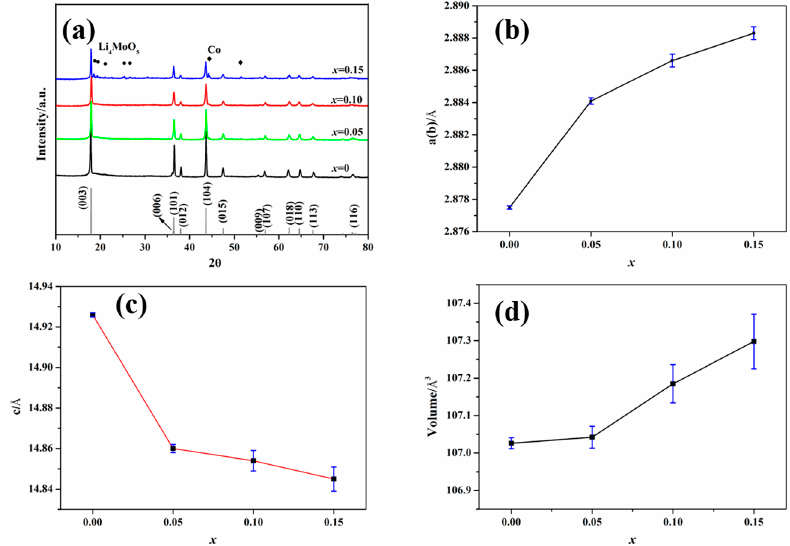
Figure 3. ( a ) XRD patterns, ( b ) a(b)-parameters in the lattice, ( c ) c-parameters, and ( d ) unit cell volume of the synthesized Li 2 Mo 1 − x Co x O 3 ( x = 0, 0.05, 0.10, 0.15).